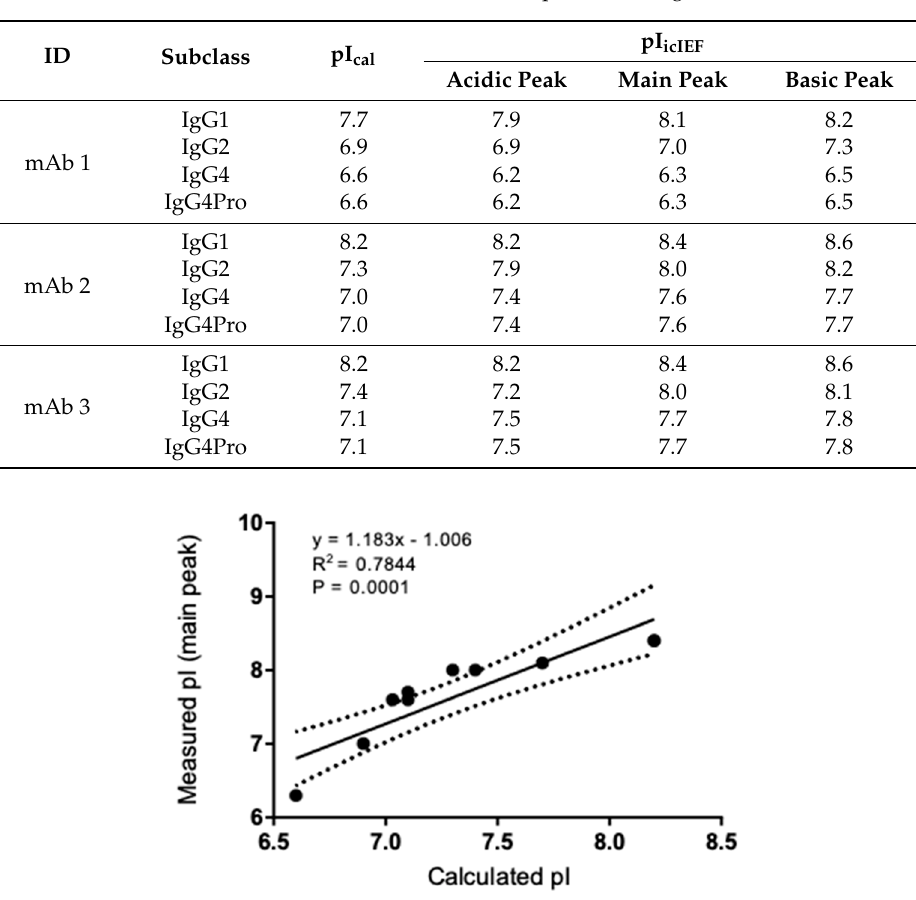
Figure 3. Electrophoretogram image of mAb1 IgG1. The peaks to the left and to the right of the main peak indicates acidic and basic charge variant, respectively. Table 3. Measured and calculated pI values of IgG.